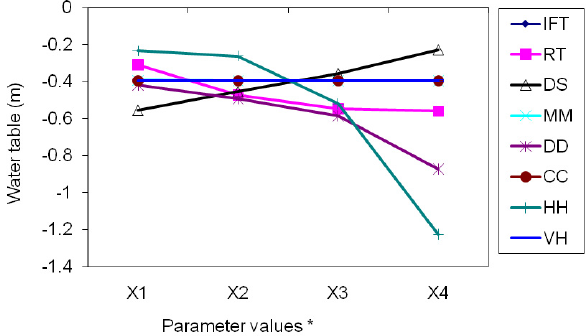
Fig.3b. Sensitivity of water table to parameter inputs Fig. 3b. Sensitivity of water table to parameter inputs *: X1=10, *: X1 = 10, X2 = 30, X3 = 50 and X4 = 70 m 1/3 s -1 for Manning M (MM); 5, 25, 50 and 100 mm for detention storage X2=30, X3=50 and X4=70m 1 / 3 s − 1 for Manning M (MM); 5, (DS); 5, 25, 50 and 100 cm for Drainage depth (DD); 1x10 -6 , 4x10 -5 , 4x10 -4 and 5x10 -3 ms -1 for horizontal hydraulic 25, 50 and 100mm for detention storage (DS); 5, 25, 50 and conductivity (HH); 5x10 -7 , 5x10 -6 , 5x10 -5 and 1x10 -4 ms -1 for vertical hydraulic conductivity (VH); 30, 50, 70 and 90 100cm for Drainage depth (DD); 1 × 10 − 6 , 4 × 10 − 5 , 4 × 10 − 4 cm for plant rooting depth (RT); 0.05, 0.2, 0.4 and 0.8 mm for coefficient of canopy interception (CC); 8x10 -6 , 8x10 - and 5 × 10 − 3 ms − 1 for horizontal hydraulic conductivity (HH); 5 , 8x10 -4 and 1x10 -3 ms -1 for infiltration rate (IFT) 5 × 10 − 7 , 5 × 10 − 6 , 5 × 10 − 5 and 1 × 10 − 4 ms − 1 for vertical hy- draulic conductivity (VH); 30, 50, 70 and 90cm for plant rooting depth (RT); 0.05, 0.2, 0.4 and 0.8mm for coefficient of canopy interception (CC); 8 × 10 − 6 , 8 × 10 − 5 , 8 × 10 − 4 and 1 × 10 − 3 ms − 1 for infiltration rate